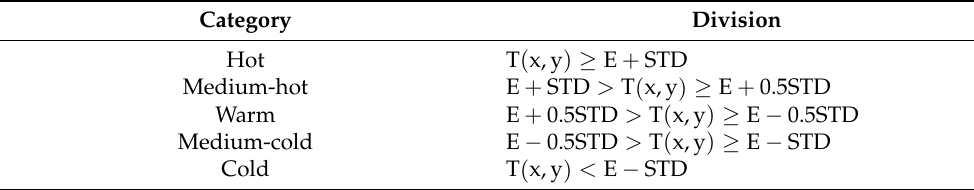
Table 2. Thermal classification based on the mean (E) and standard deviation (STD). Category